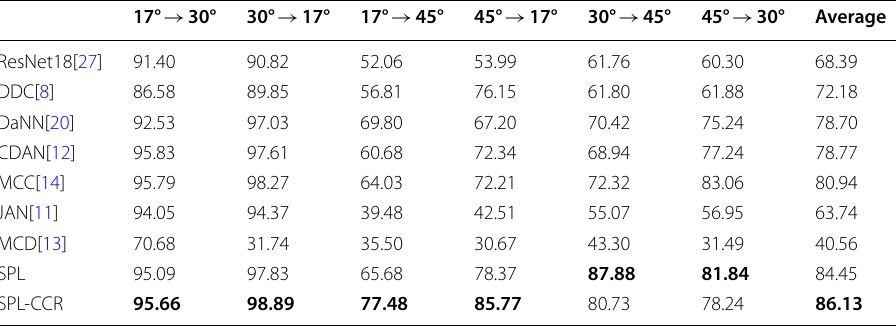
Table 7 Classification results of different methods with 30 samples randomly selected for each class 17° →